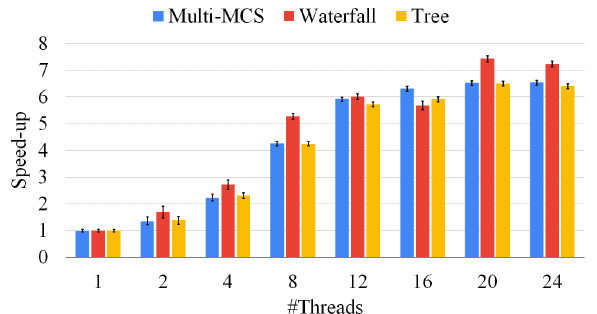
Figure 11. Speed up of our algorithms using an increasing number of threads, varying from 1 (purely sequential) to 24. The plot compares the Multi-MCS strategy of Section 3.2, with the Multi-quasi-MCS strategies of Section 4.1, the waterfall strategy, and Section 4.3, the tree approach. We report average resolution times over 10 runs. The standard deviation of the ten runs is reported on top of each bar.